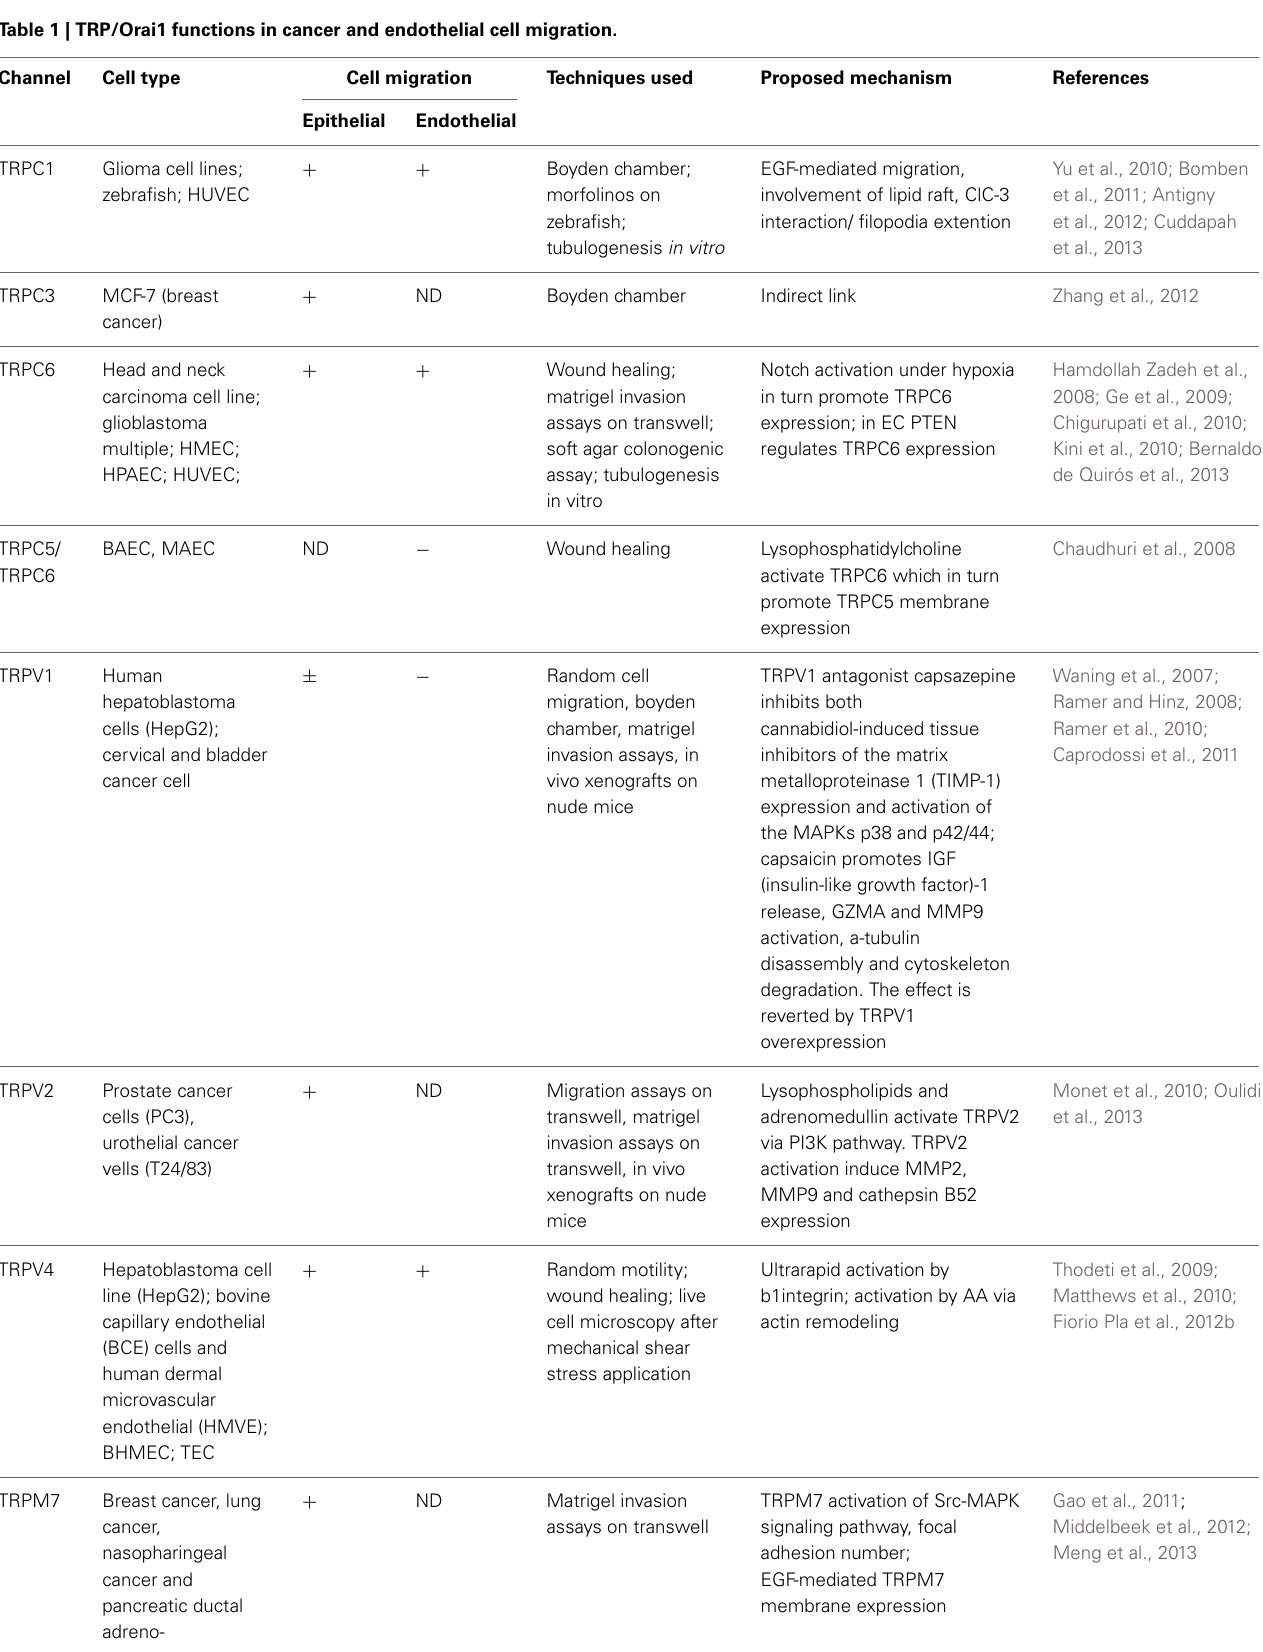
Table 1 | TRP/Orai1 functions in cancer and endothelial cell migration.